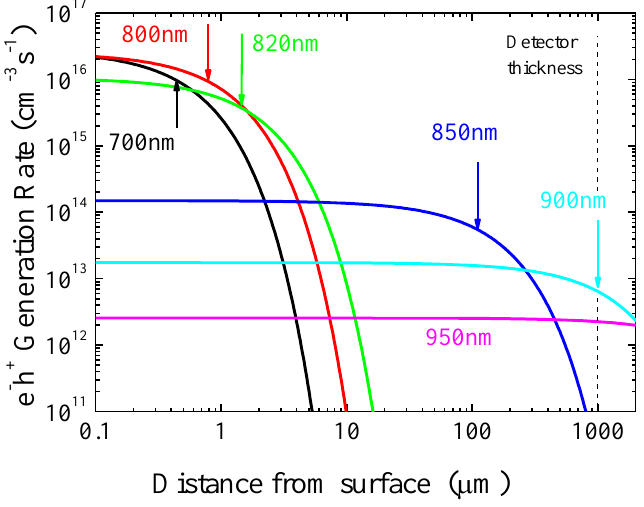
Figure 2. Spatial distribution of the electron-hole generation rate for different wavelengths, calculated assuming no reflections or contact absorption. The arrows denote the penetration depth for each wavelength. At 950 nm the penetration depth is about 2 mm. The dashed vertical line indicates the detector thickness (1